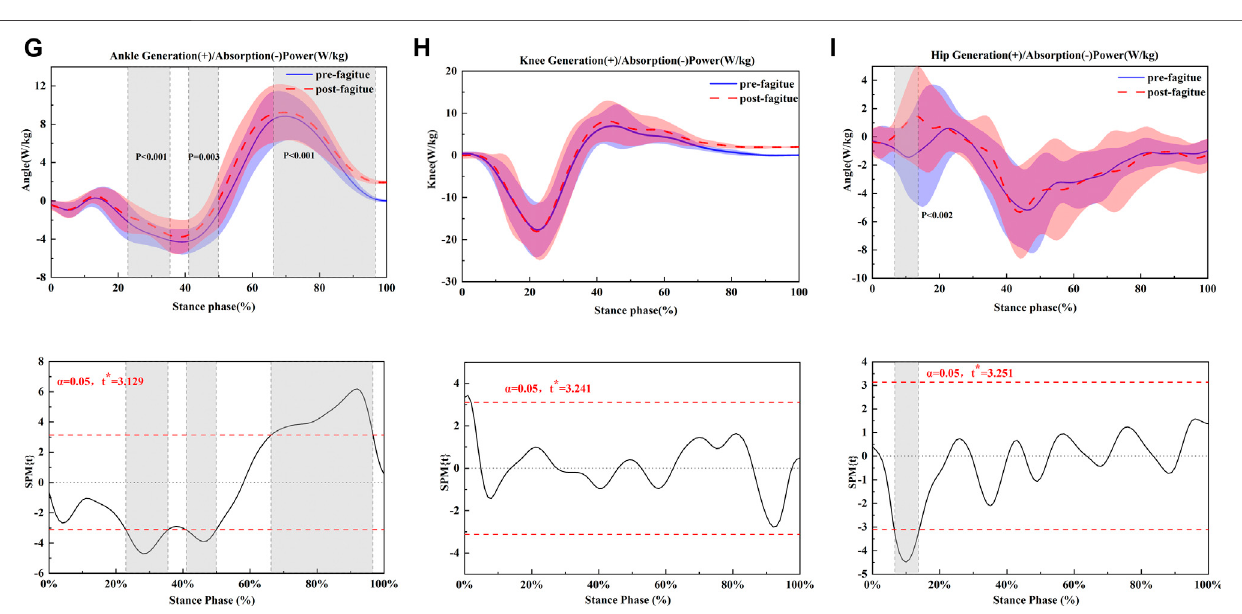
FIGURE 3 | Comparing the mean values of ankle, knee and hip joint power from all participants between fatigue conditions (pre-fatigue; post-fatigue). * p ≤ 0.05.